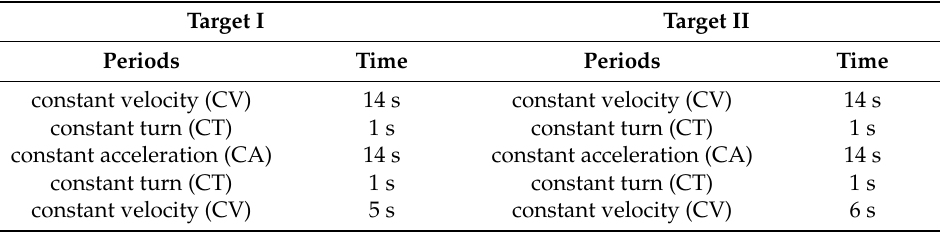
Table 1. Dynamic models of two crossing